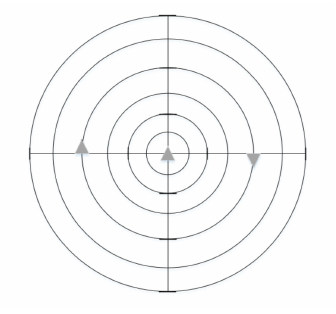
Figure 2. Radar-Vision cooperative target.